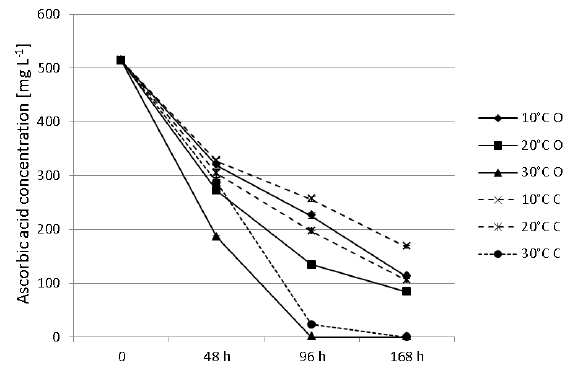
Figure 7: Changes in ascorbic acid concentration during storage of freshly squeezed orange juice in open (O) and closed (C) containers.